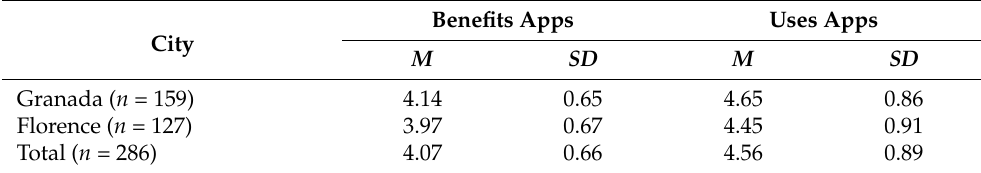
Table 4. Mean and standard deviation of the benefits and uses of apps according to each